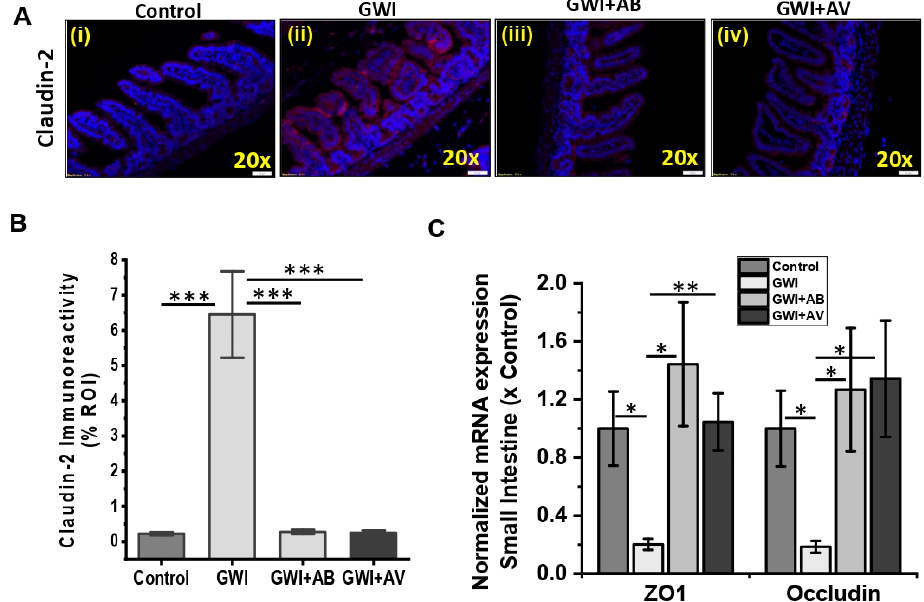
Figure 4. Anti-viral or antibiotic intervention improves intestinal epithelial membrane integrity and tight junctions in GWI. ( A , B ) Representative immunofluorescence images of small intestine showed Claudin-2 (red) expression and localization in Control, GWI (Gulf War chemical exposed mice), GWI + AB (Gulf War chemical and antibiotic exposed mice), and GWI + AV (Gulf War chemical and antiviral-treated mice). All intestine sections were counterstained with DAPI (blue) and 3–10 images were taken from the different microscopic field of each group at 20× magnification. The morphometric analysis (calculated as % ROI of red immunofluorescence image ( n = 3–10)) of images were plotted as a bar graph as Claudin-2 ( B ). ( C ) mRNA expression of epithelial tight junction proteins ZO1 and Occludin in GWI, GWI + AB and GWI + AV groups. Data points were represented with means ± SEM. Statistical significance was calculated using unpaired t -test; * p < 0.05, ** p < 0.01, *** p < 0.001.